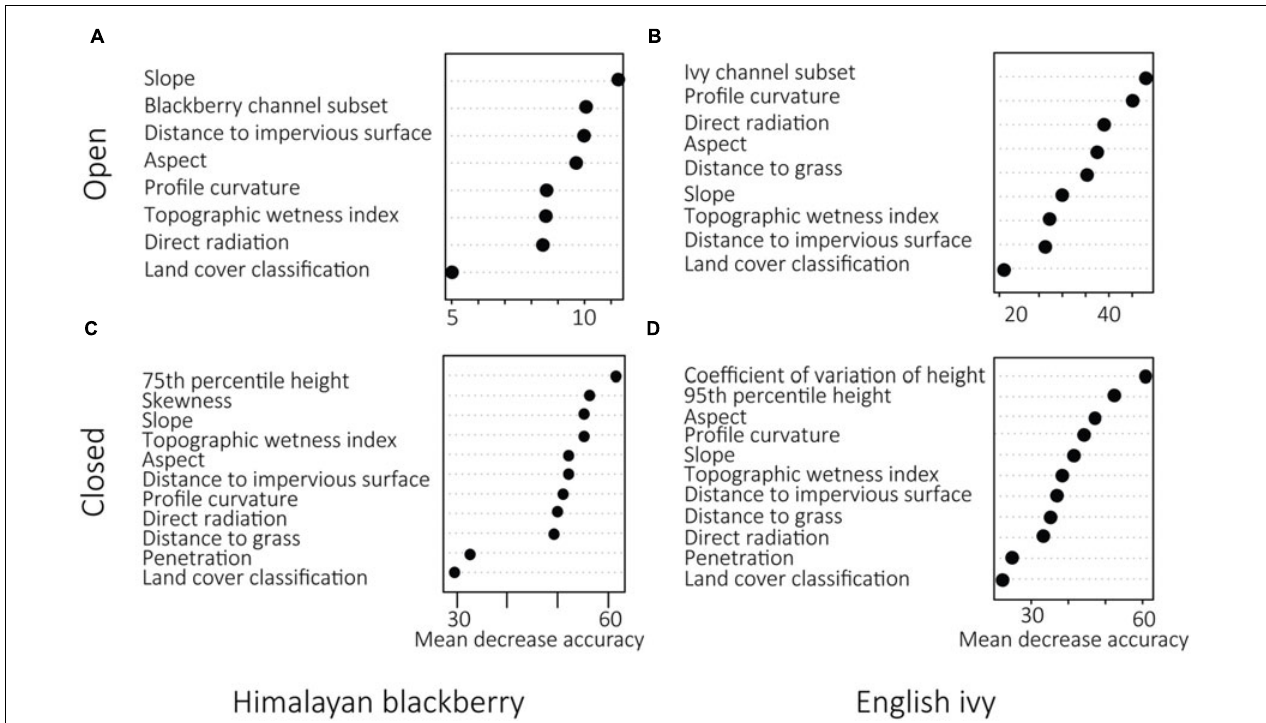
FIGURE 5 | Variable importance as expressed by mean decrease accuracy (% decrease in overall accuracy) determined by random forest classifications in open areas (A,B) and areas with closed canopies (C,D) for Himalayan blackberry ( Rubus armeniacus ) and English ivy ( Hedera helix ) distributions across Surrey, BC,